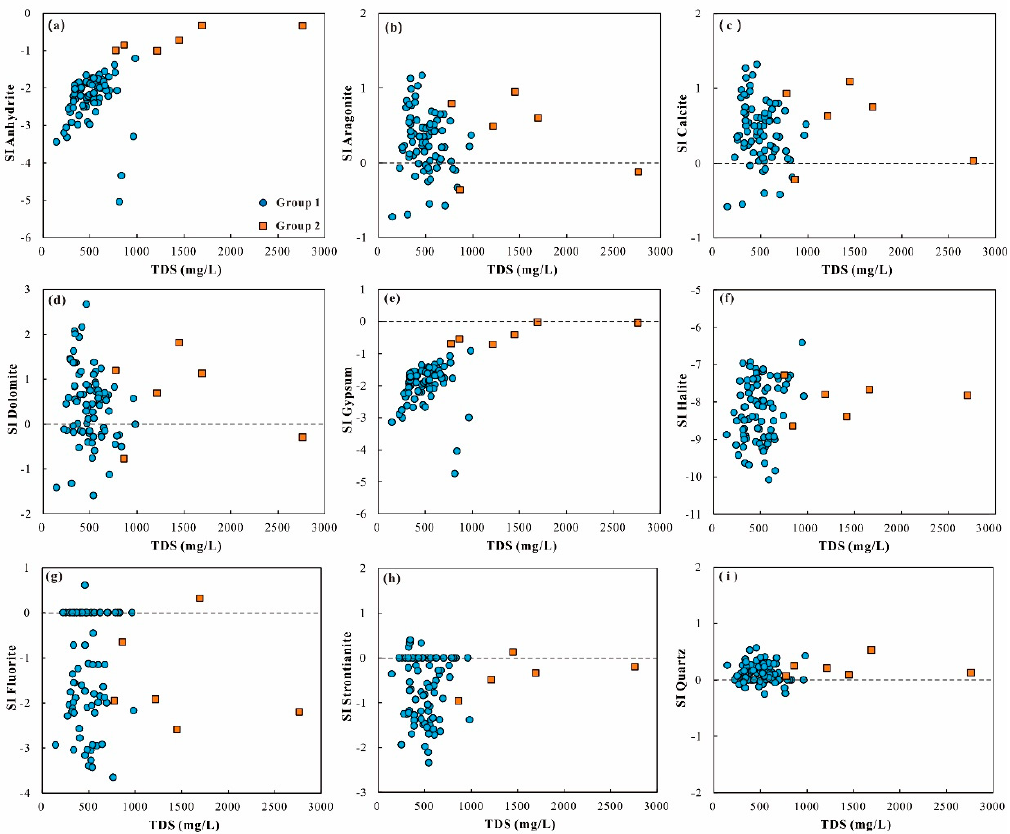
Figure 8. Scatterplots of saturation indices of ( a ) anhydrite, ( b ) aragonite, ( c ) calcite, ( d ) dolomite, ( e ) gypsum, ( f ) halite, ( g ) fluorite, ( h ) strontianite, and ( i ) quartz vs. total dissolved solids (TDS) for groundwater samples.